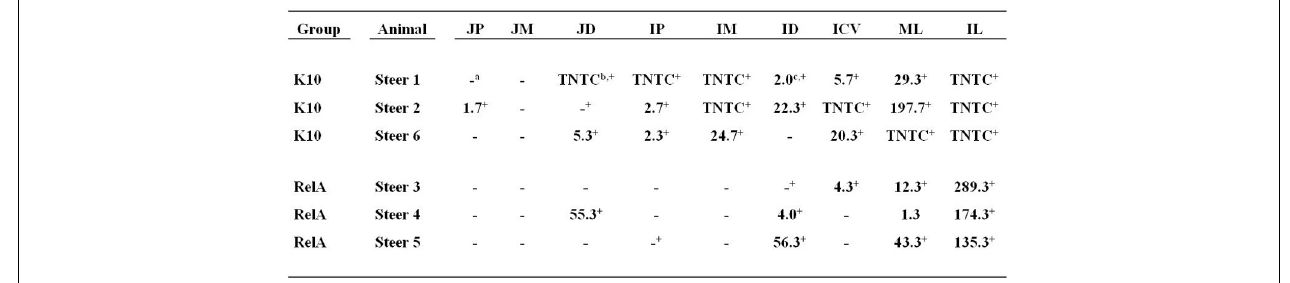
animal. JP, JM, JD: jejunum proximal, middle, distal; IP, IM, ID: ileum proximal, middle, distal; ICV: ileocecal valve; ML, IL: mesenteric and ileocecal lymph nodes. a, Negative; b, too numerous to count; c, Values are expressed as the average CFU obtained from three agar cultures; + , positive by IS900 qPCR.